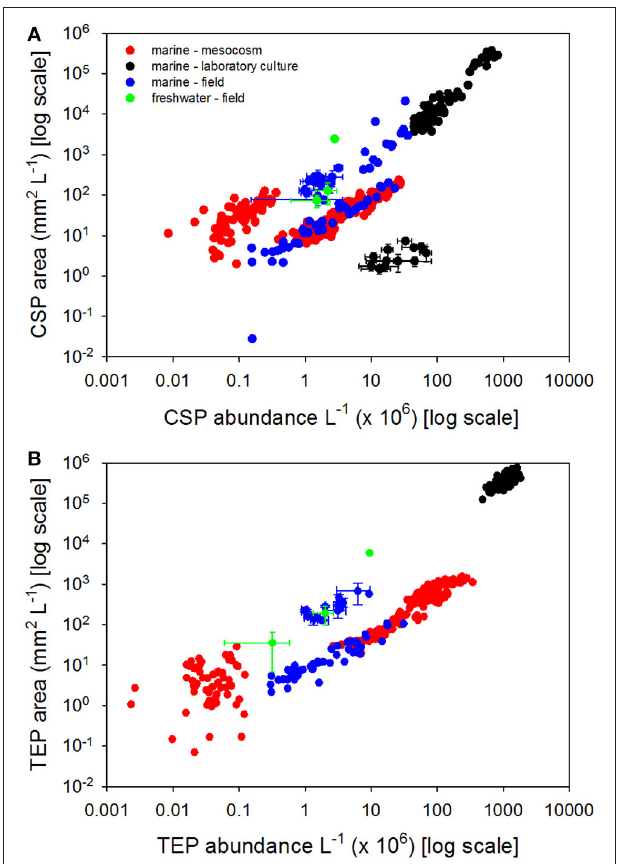
FIGURE 2 | Coomassie stainable particle (CSP) concentrations and abundance . (A) Concentration of CSP expressed as particle area with CSP abundance. (B) Concentration of transparent exopolymer particles expressed as particle area with TEP abundance. Color coding indicates the environment that the samples were taken: red circles indicate marine meso- or microcosm experiments, black circles indicate laboratory cultures, blue circles indicate marine field samples, green circles indicate freshwater field samples. Data points represent single measurements, or means where error bars ( ± SD) are shown. Data are a compilation from the following papers: Long and Azam (1996) , Berman and Viner-Mozzini (2001), Carrias et al. (2002), Prieto et al. (2002) , Bhaskar et al. (2005), Radi ´ c et al. (2006), Grossart et al. (2006), Lemarchand et al. (2006), Luef et al. (2007), Endres et al. (2013), Galgani